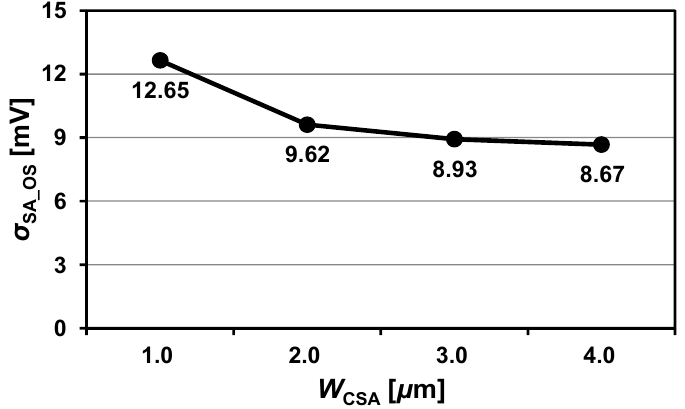
Electronics 2020 , 9 , x FOR PEER REVIEW σ Figure 9. Average σ SA_OS of the OCZS-SA according to W CSA when L CSA = 0.2 μ m. Figure 9. Average SA_OS of the OCZS-SA according to W CSA when L CSA